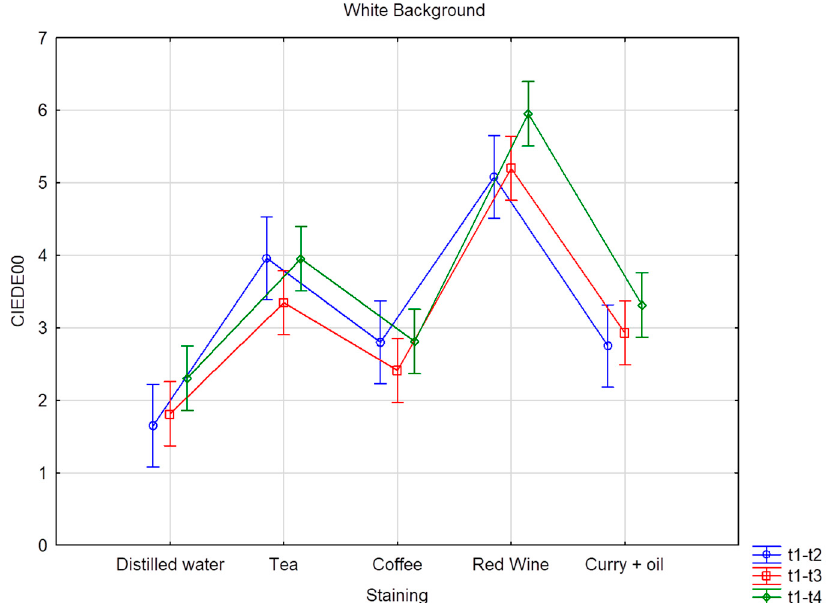
Figure 1. Average color difference in terms of CIEDE00 over time according to different staining liquids analyzed over a white background. Vertical bars denote 95% confidence intervals.